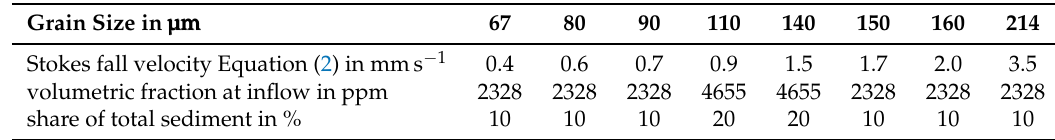
Table 2. Characteristic grain size distribution used for the numerical model of the venting experiments